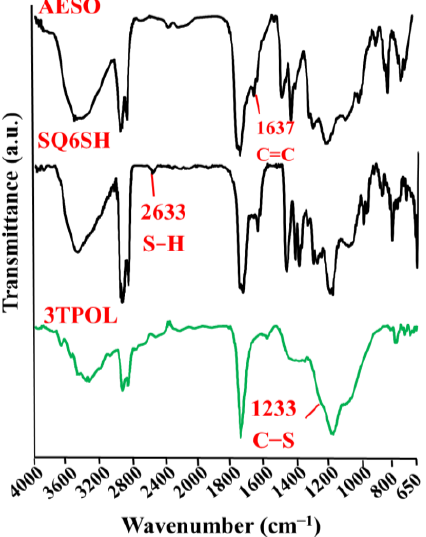
Figure 3. FT-IR spectra of AESO, SQ6SH, and 3TPOL.